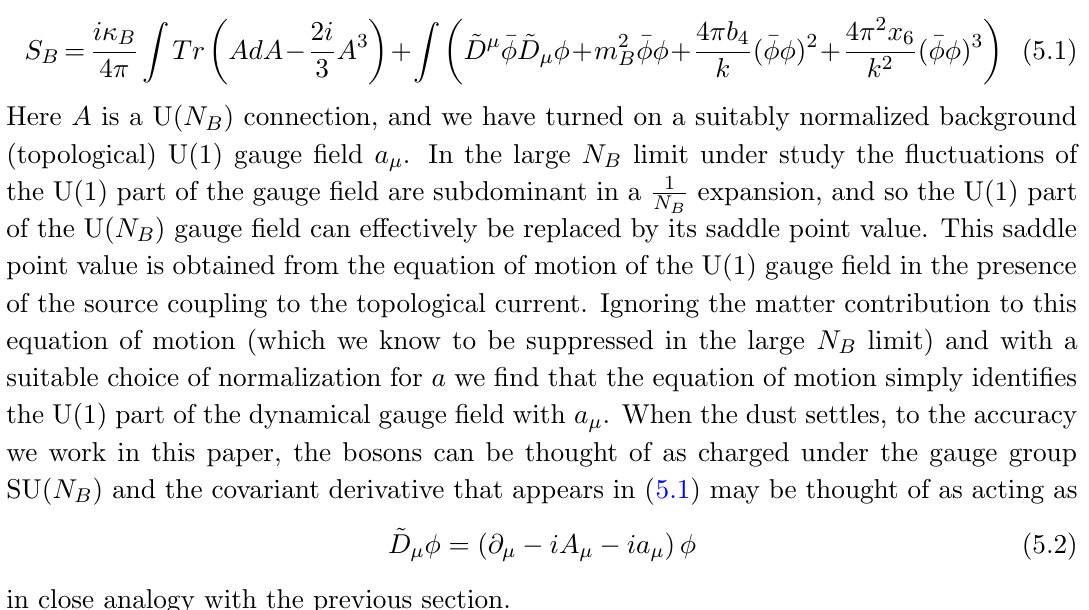
(a) Dashed lines are from fermionic perturbation theory. Solid lines are from numerical analysis. Figure 9. Exceptional energy band as a function of (cid:21) F for sgn(b (cid:21) F ) = (cid:0) 1, sgn(m F (cid:21) F ) = (cid:0) 1 at p m cri = (cid:0) j b j B